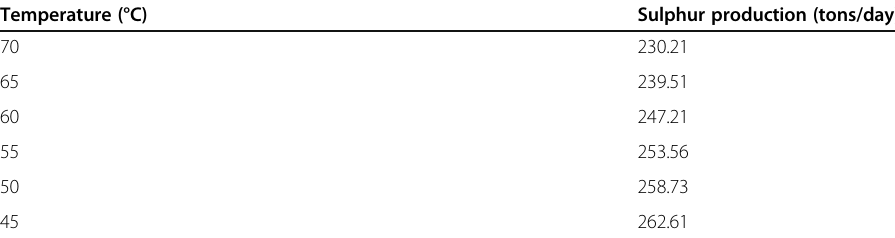
Table 15 Sulphur production versus AAG to amine drum stream temperature Temperature